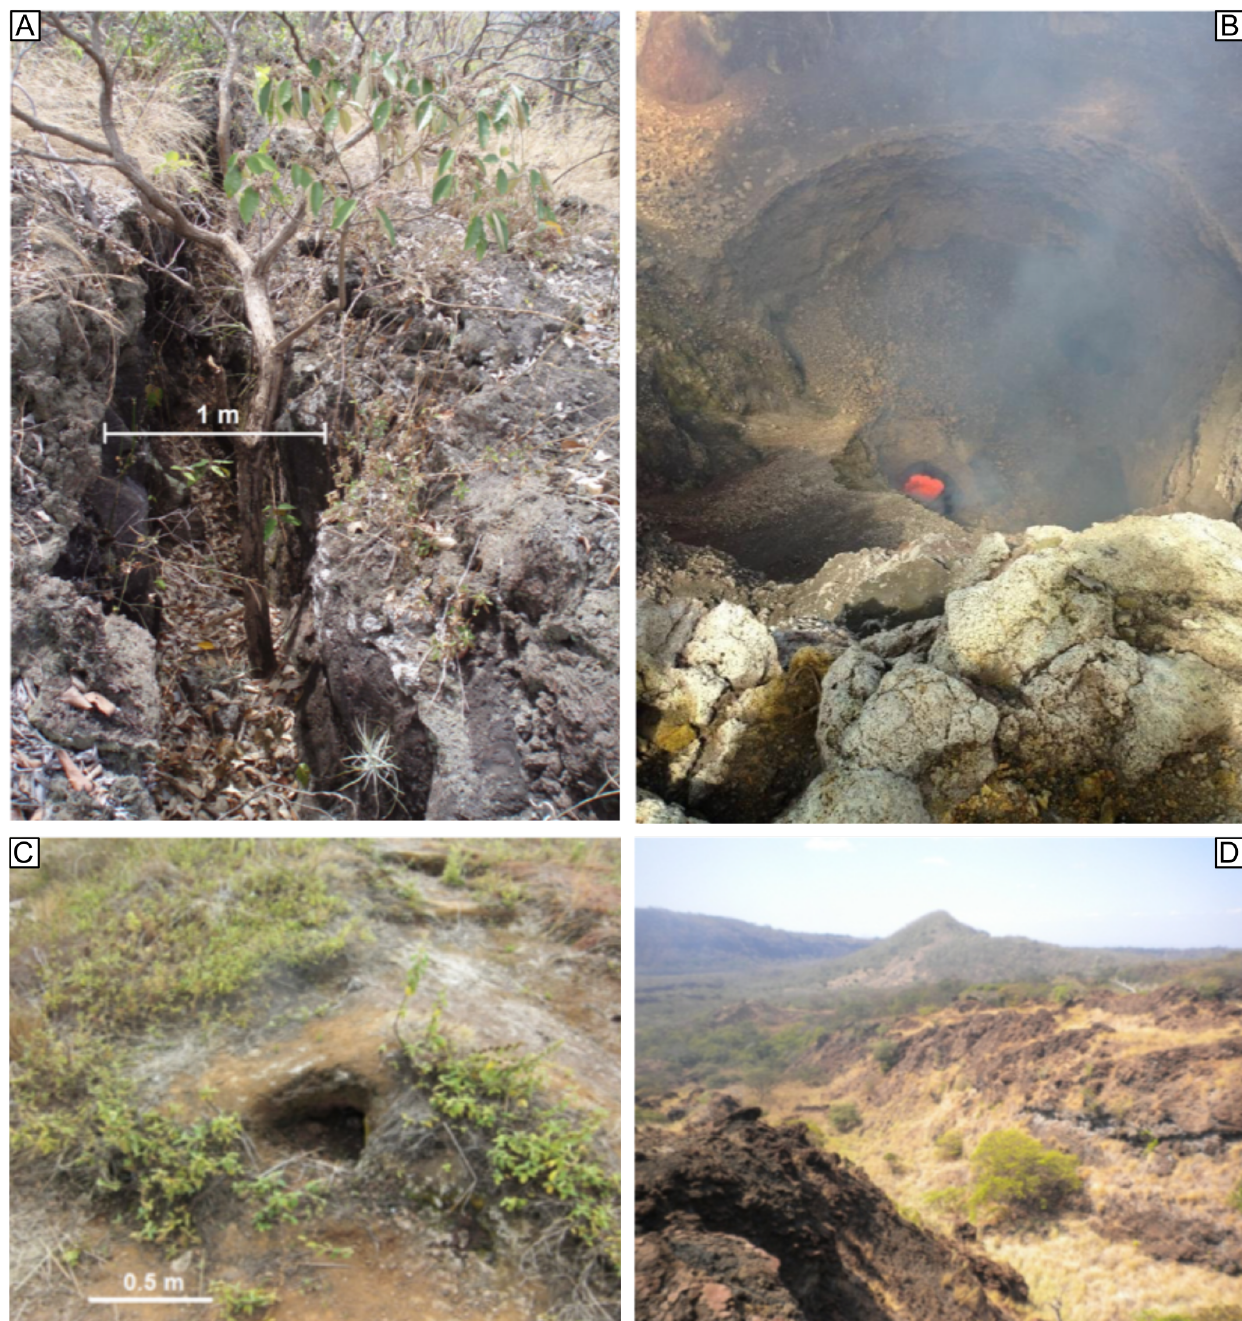
Figure 3: Examples of [A] recent opening or crack (O1); [B] active vent in Santiago crater (MC3); [C] fumarole in Comalito (F7); [D] cinder cone in Cerro Montoso (MS3). [Continued on next